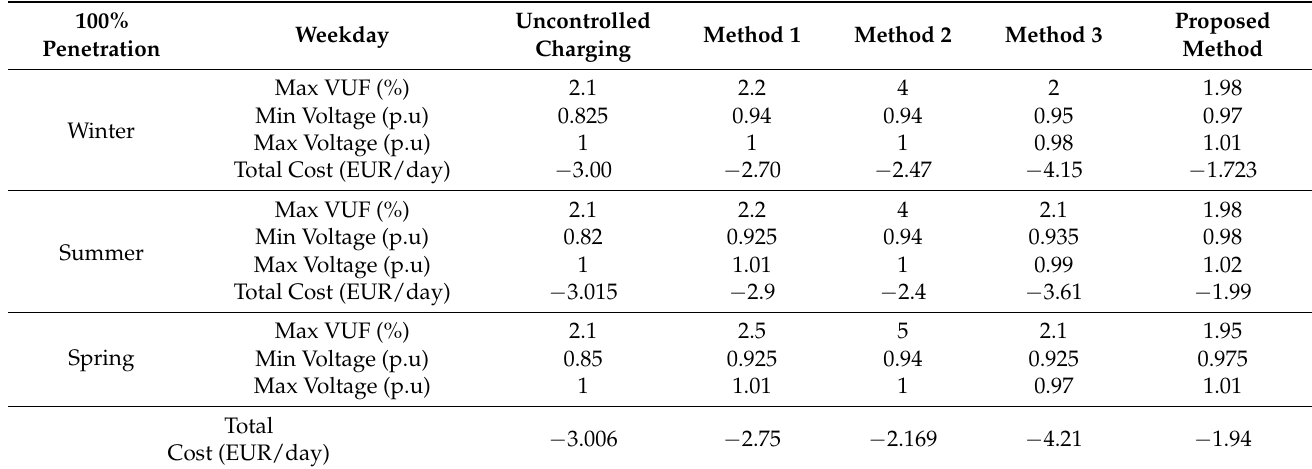
Table 5. Comparison results of case study under different price signals.